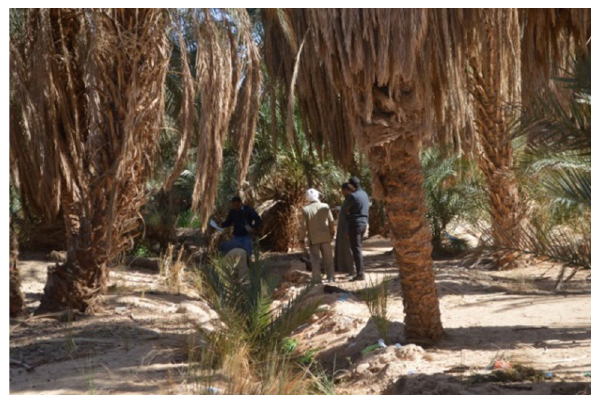
Fig. 4 January 22, 2018, investigations of the seguias of the foggara of Tamllal. (photo. Authors 2018)